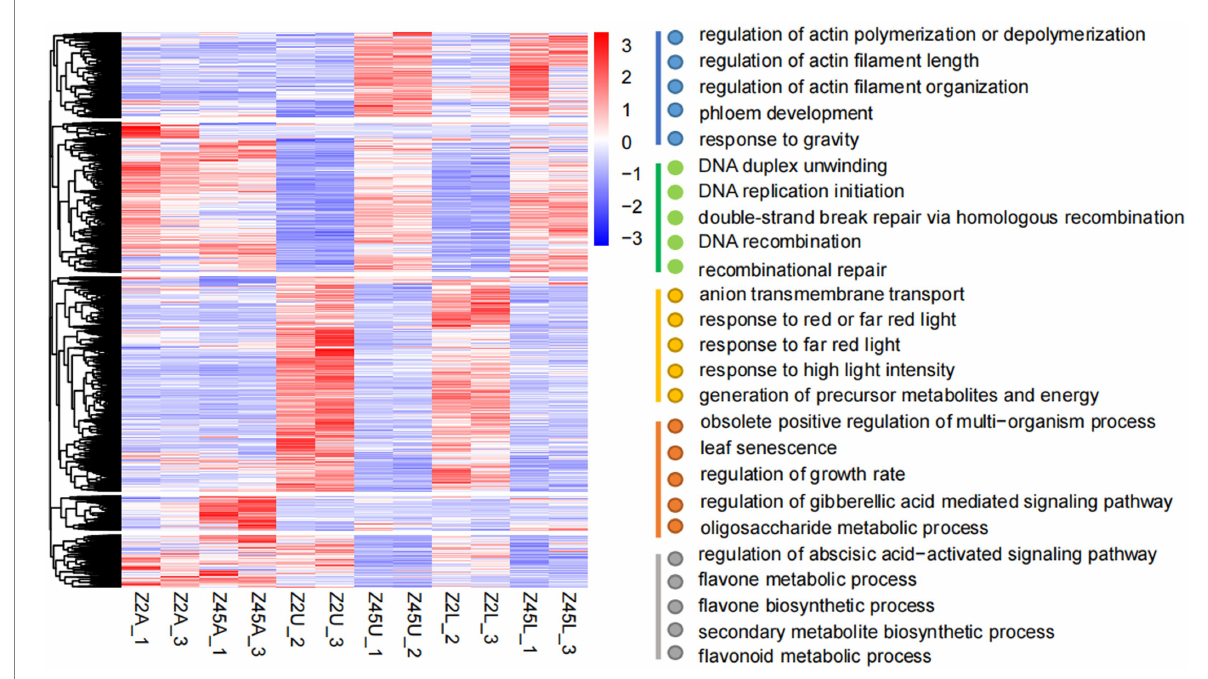
FIGURE 5 Cluster analysis of 12,686 DEGs. The gene expression pattern of DEGs were shown by heat map, and clustered into five modules. GO enrichment analysis (biological process) was performed on these five